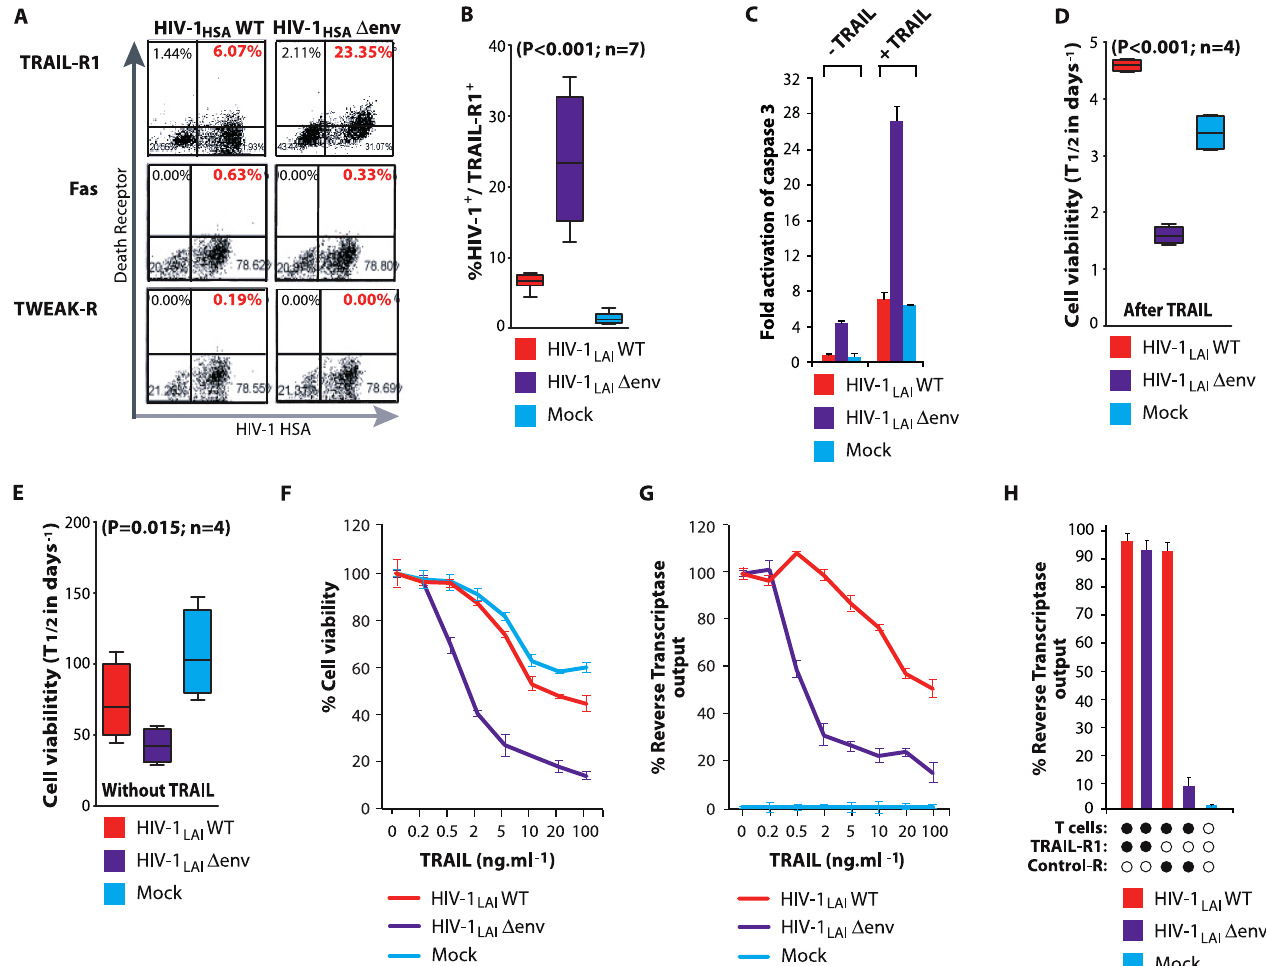
Figure 2. Death Receptor Expression on Macrophages Infected with Wild-Type or Envelope-Minus HIV-1 Variants (A) Macrophages were infected with VSV-pseudotyped wild-type HIV-1 (HIV-1 HSA WT) or envelope-minus (HIV-1 HSA D env) variants expressing HSA in place of Vpr. Levels of TRAIL-R1, Fas, and TWEAK-R expression on infected (HSA positive) cells was determined by flow